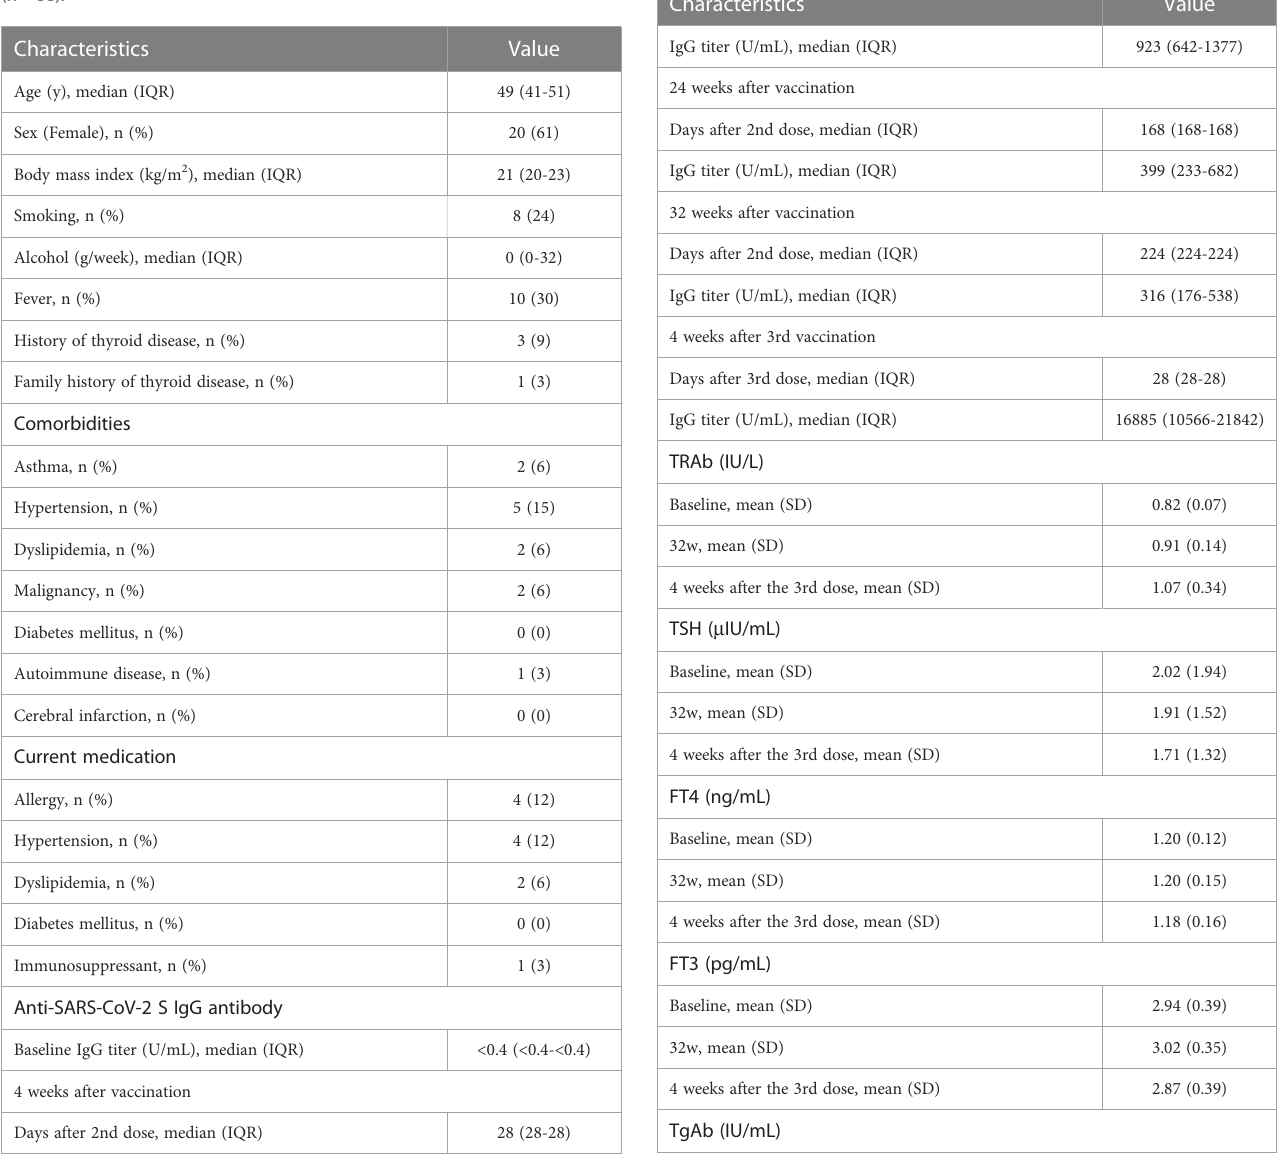
TABLE 3 Baselinecohort characteristics for TgAb and TPOAb analysis (n=